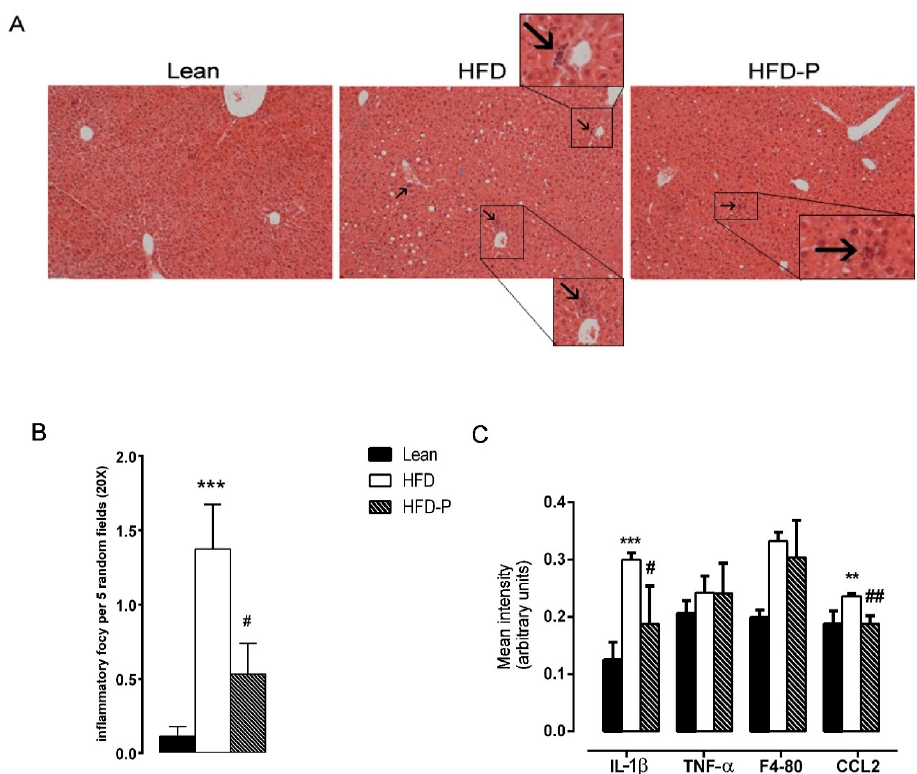
Figure 4. Effect of pistachio consumption on liver inflammation. ( A ) Liver histology of the lean, HFD, and HFD-P mice was examined by H&E staining. Arrows indicate the points of inflammatory foci (magnification 10×). ( B ) Quantification of inflammatory foci per 5 random fields under 20× magnification. ( C ) mRNA levels of IL-1 β , TNF- α , F4-80, and CCL2 in the livers of the lean, HFD, and HFD-P mice ( B ). Data are represented by the means ± SEM. ( n = 8/group). * p < 0.05 compared to the lean mice (** p < 0.01; *** p < 0.001); # p < 0.05 compared to the HFD mice (# p < 0.05; ## p <